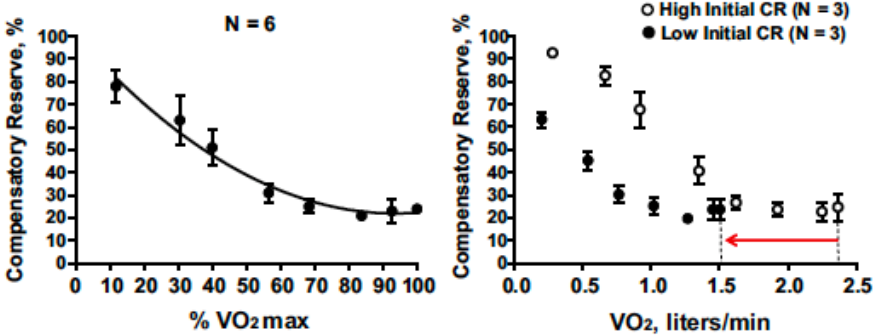
Figure 7. Compensatory reserve measure responses to progressive increases in aerobic exercise intensity (percent maximal aerobic power) that result in maximal exertion ( left ). On the ( right ), low baseline CRM (filled circles with 95% confidence intervals) is associated with lower maximal aerobic power (VO2max) compared to subjects with high initial CRM (open circles with 95% confidence intervals) with the final difference shown by the red arrow on the x-axis. Image from [13].